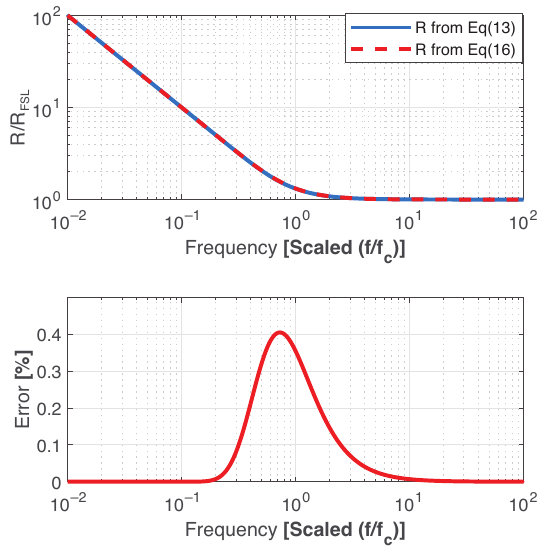
Figure 7. Equivalent resistance approximation from Equations (16) and